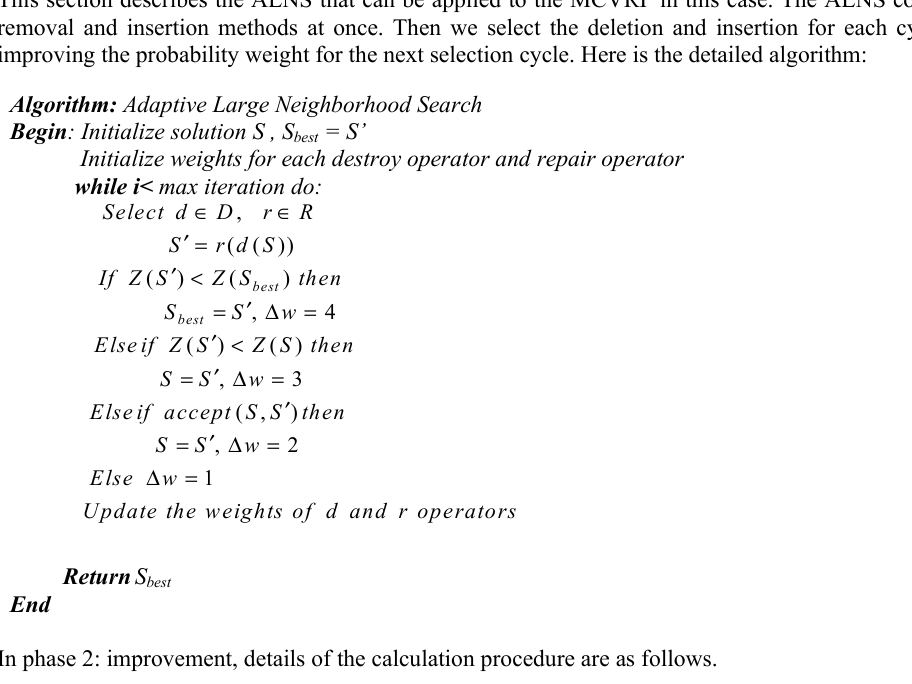
Fig. 6. TSP model for each